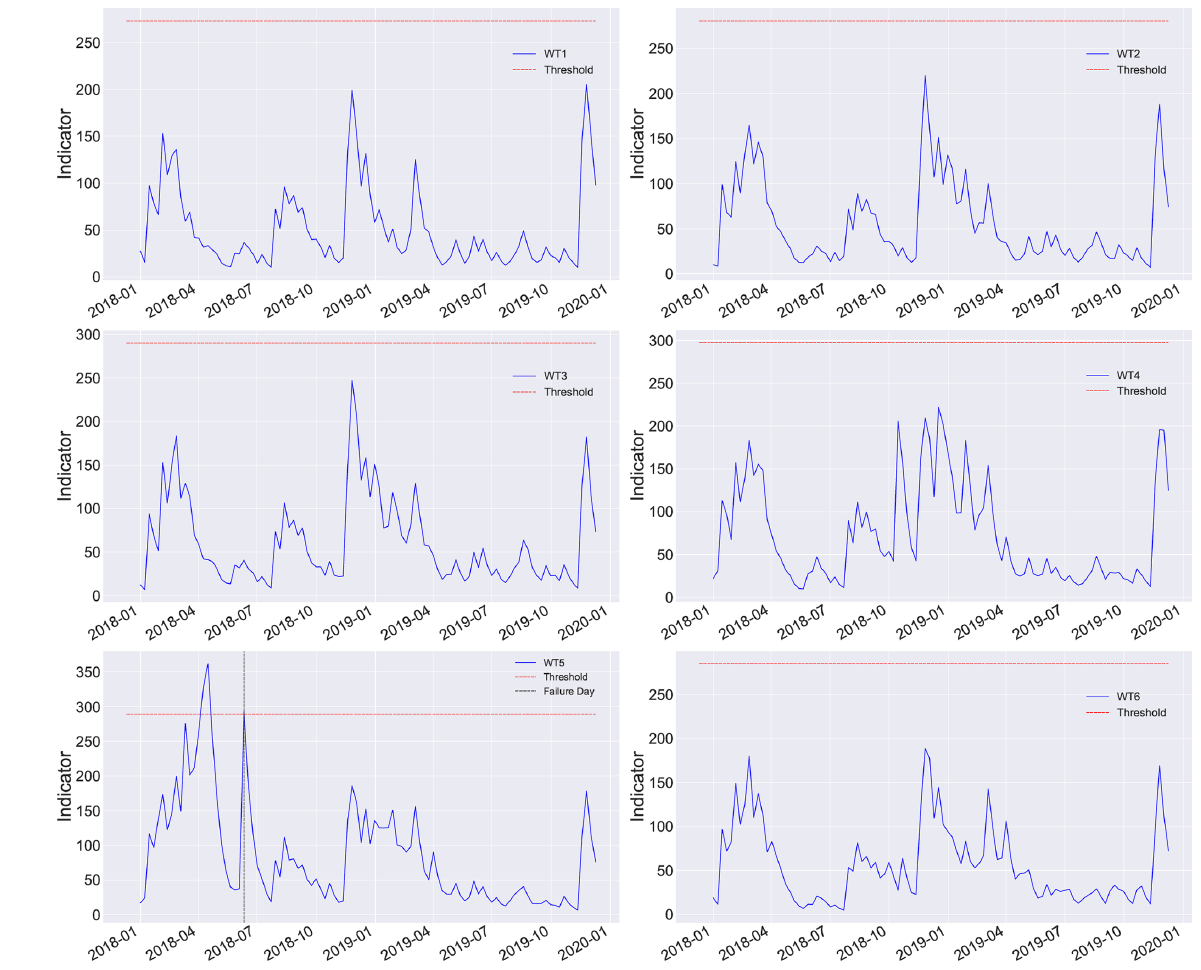
Figure 10. Weekly indicator